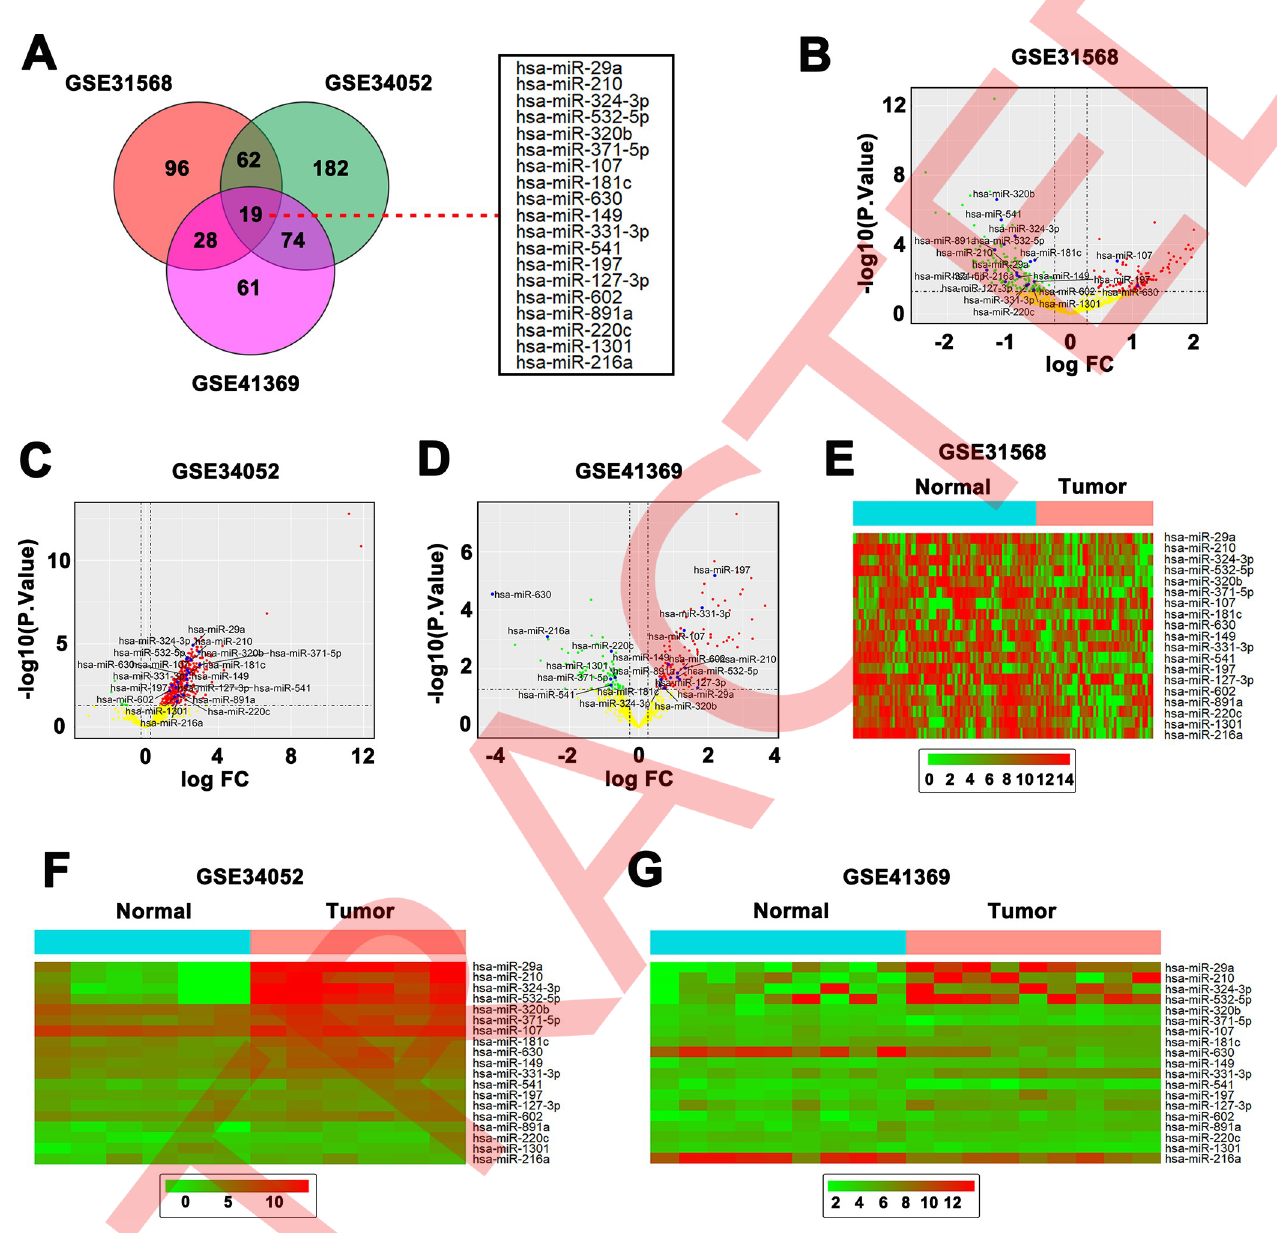
Fig 1. Comprehensive analysis of 3 pancreatic miRNAs expression datasets. (A) 3 datasets of pancreatic miRNAs expression was analyzed and 19 differentially expressed miRNAs (DEMs) were identified in the 3 data sets. (B & C & D) Volcano plot of 19 dysregulated miRNAs discovered from GSE31568, GSE34052 and GSE41369. (E & F & G) Heatmap of 19 dysregulated miRNAs mined from GSE31568, GSE34052 and GSE41369.